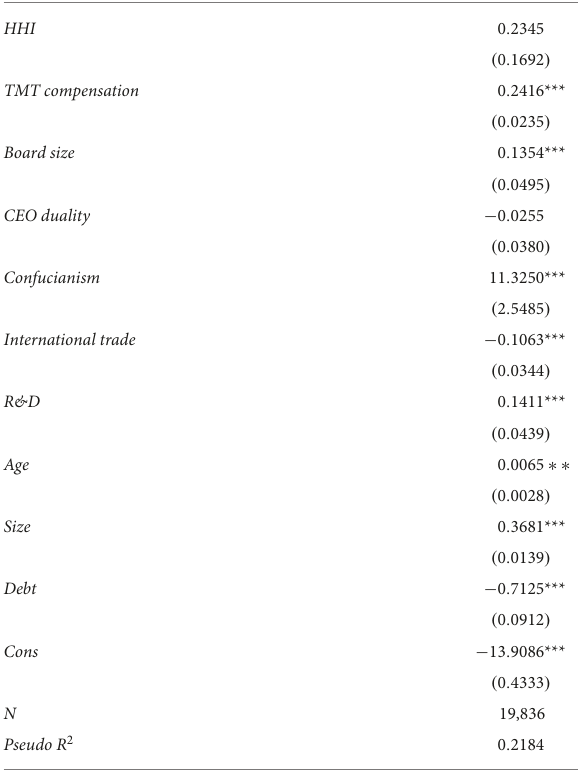
TABLE 5 Probit estimation: Firms’ probability of participating in donation. Variables